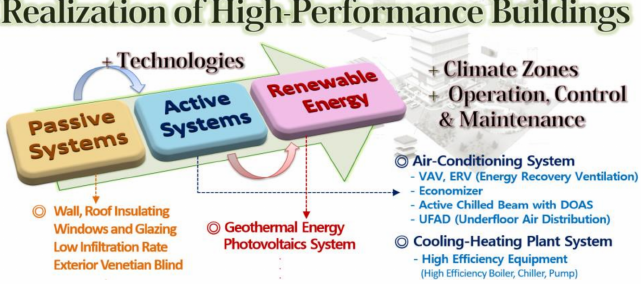
Figure 6. Method for realizing high-performance